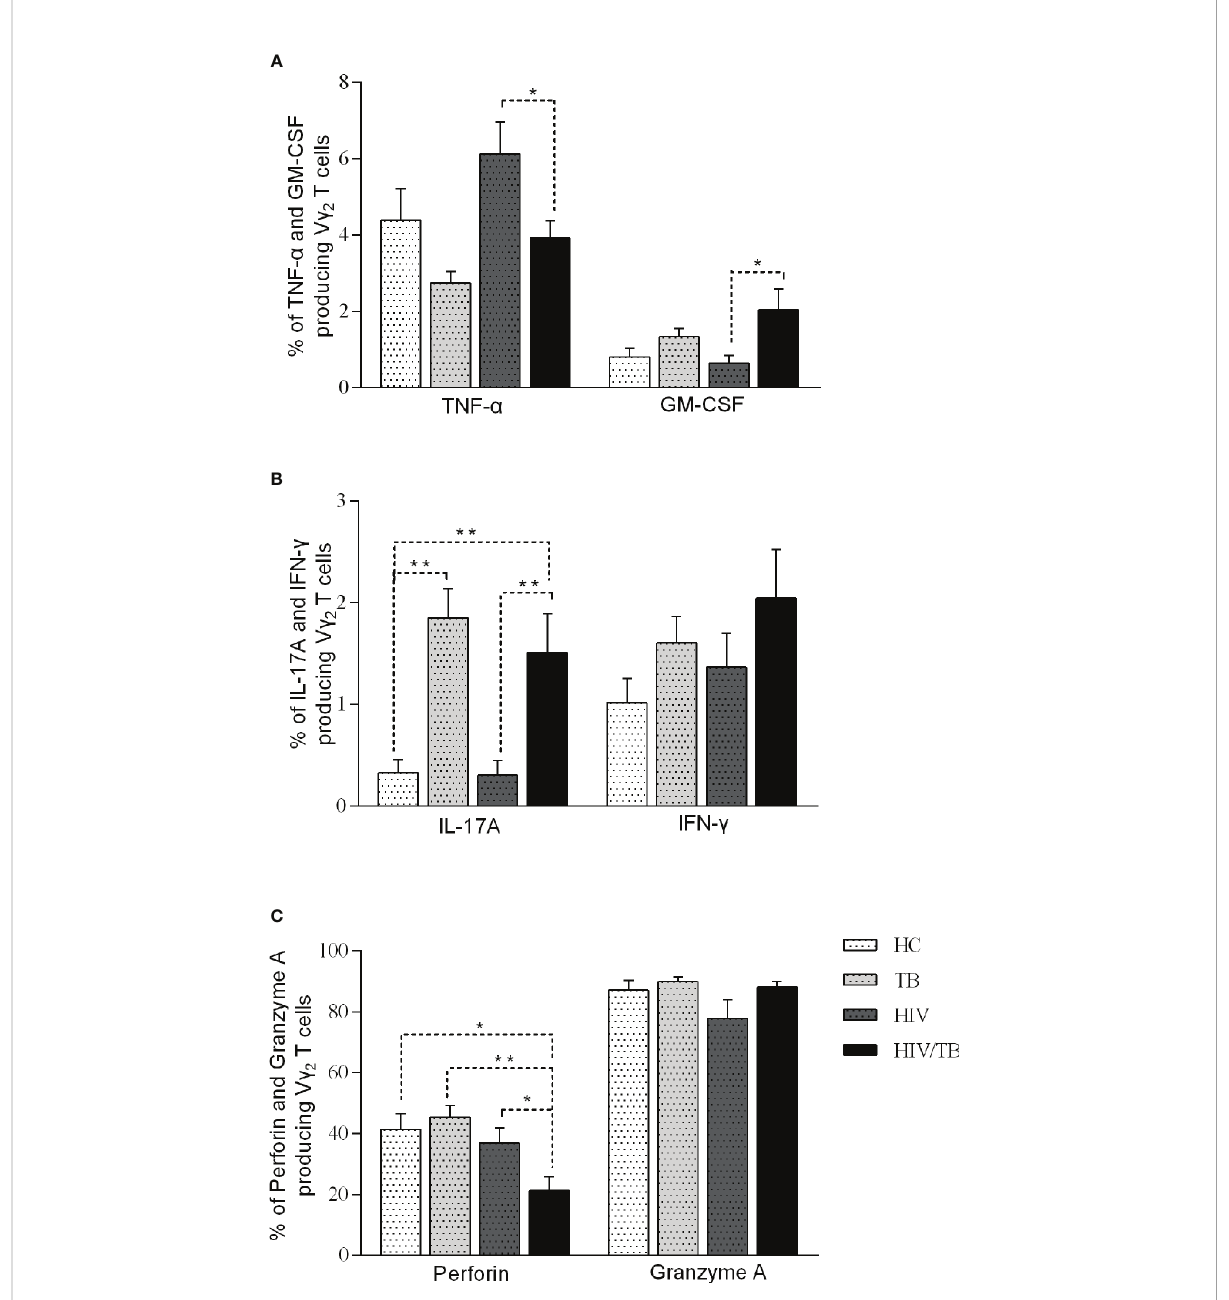
FIGURE 3 Function of V d 2 subset among each group. Subjects that produce TNF-a and GM-CSF (A) , IL-17A and IFN- g (B) , perforin and granzyme A (C) in each group are shown. P-value calculated using the Mann – Whitney U test. Statistically signi fi cant differences between the groups were indicated as follows: *P<0.05 and **P<0.01. Those that were not statistically signi fi cant were not marked intra group or inter